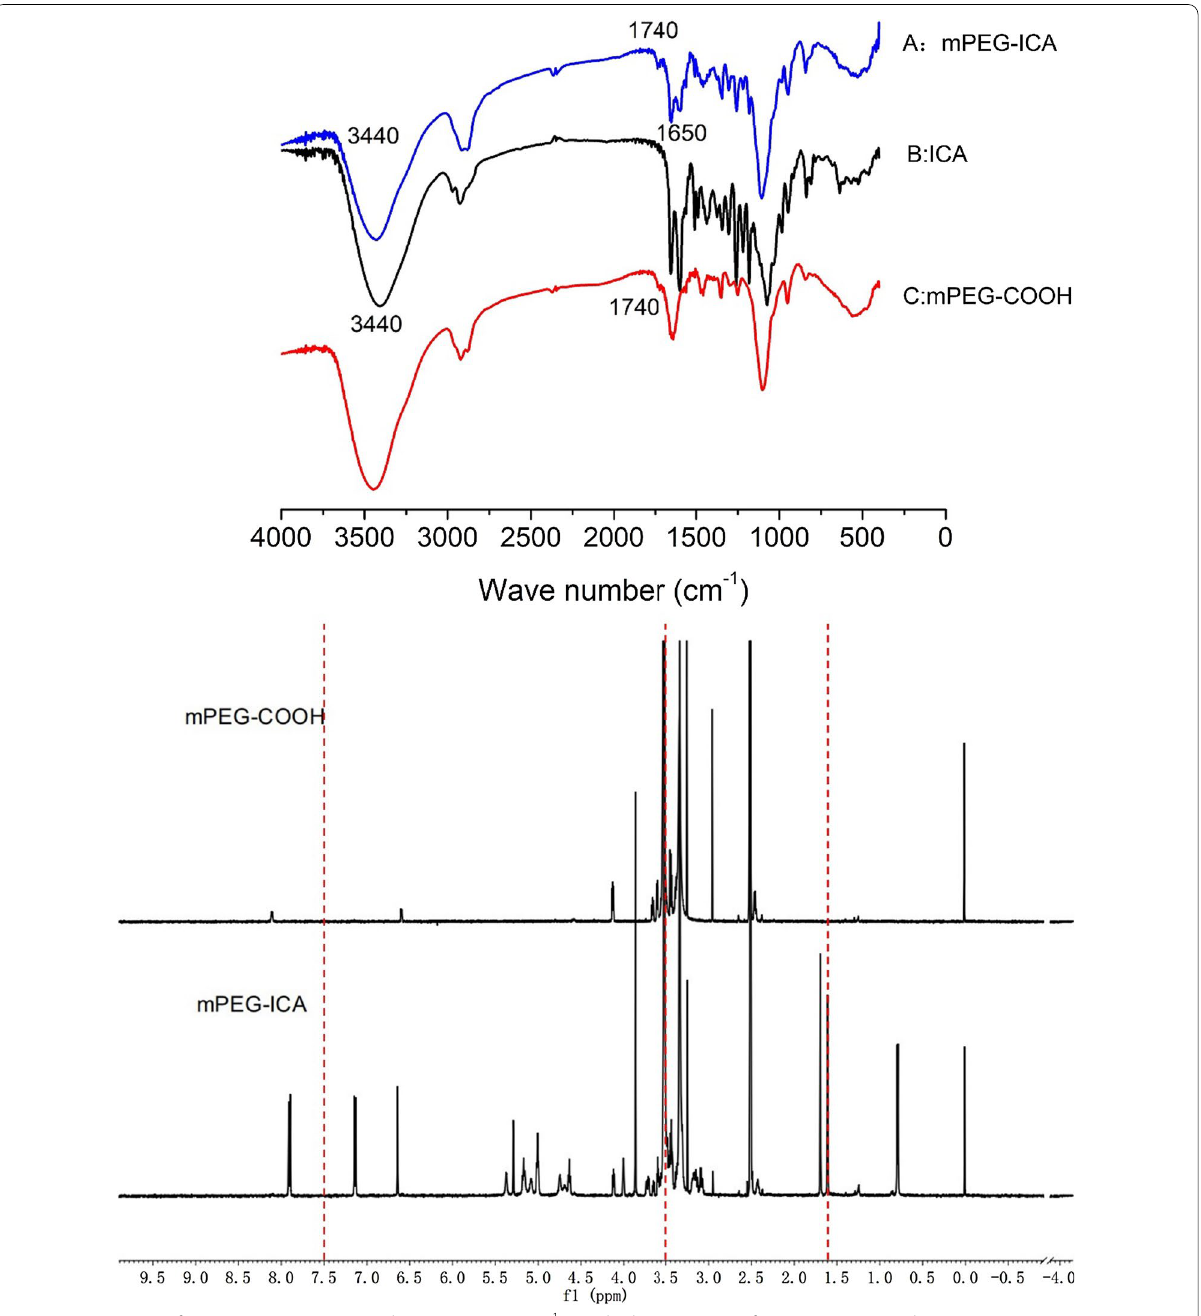
Fig. 1 FTIR spectra of mPEG-ICA ( A ), ICA ( B ), and mPEG-COOH ( C ). H 1 NMR hydrogen spectra for mPEG-COOH and